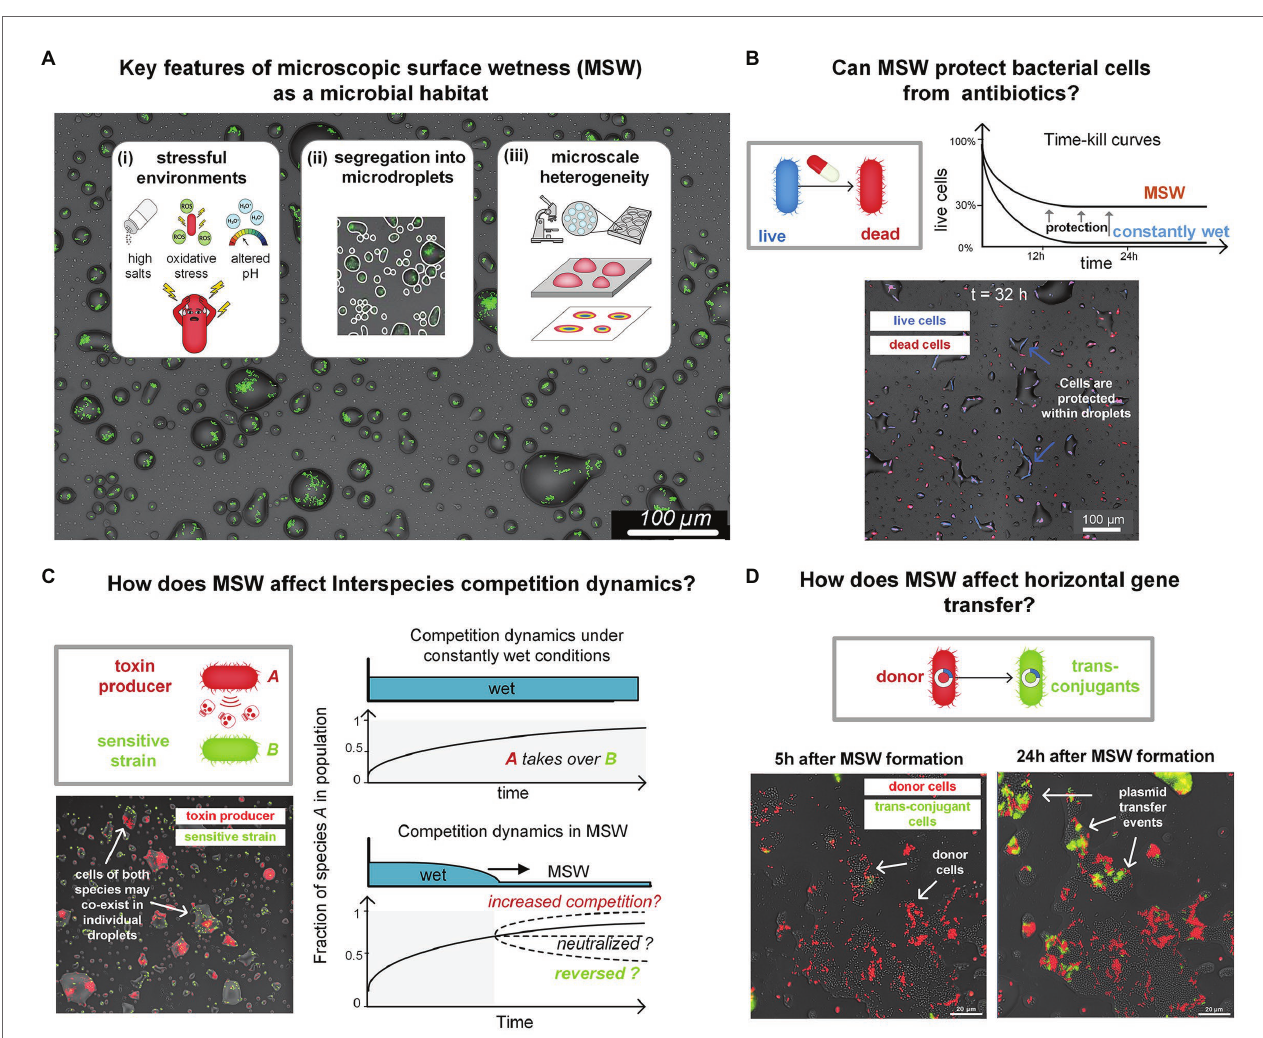
FIGURE 2 | (A) Key features of MSW as a microbial habitat. (B) Inherent properties of MSW, including very high salt concentrations and slow cell-growth protect bacteria from various antibiotics. In a recent study, we showed such protection of Escherichia coli from major antibiotic classes (e.g., beta-lactams; Beizman-Magen et al., 2020). The schematic illustration shows killing curves of E. coli in response to Ampicillin under constantly wet conditions and on a drying surface with MSW. Survival of E. coli was more than two orders of magnitude higher in MSW than in constantly wet condition. The micrograph shows cells that survive long periods of exposure to Ampicillin under MSW conditions. Live cells express BFP (blue) and dead cells are marked with propidium iodide (red). (C) Key features of MSW mentioned in (A) are predicted to impact interspecies competition dynamics. Interference competition in wet-dry cycles and MSW might, for example, be